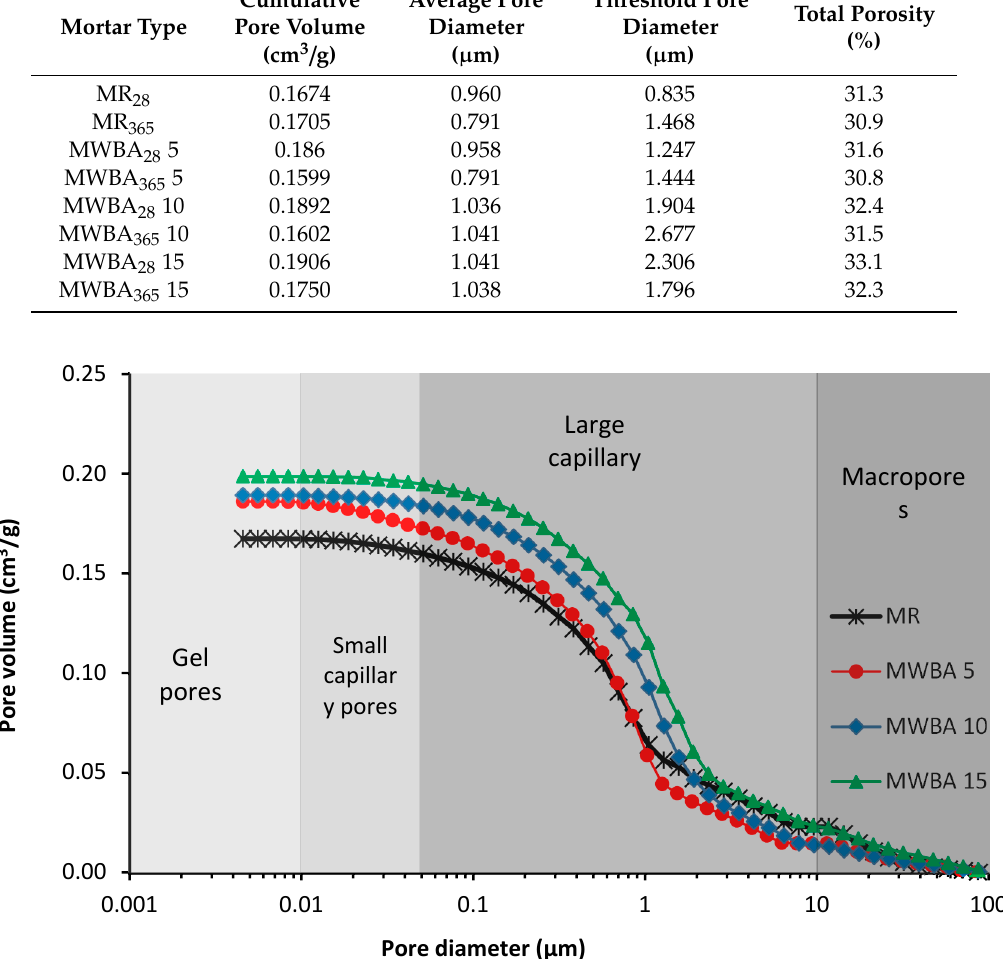
Figure 5. Pore size distribution of tested mortars: 28 day samples.